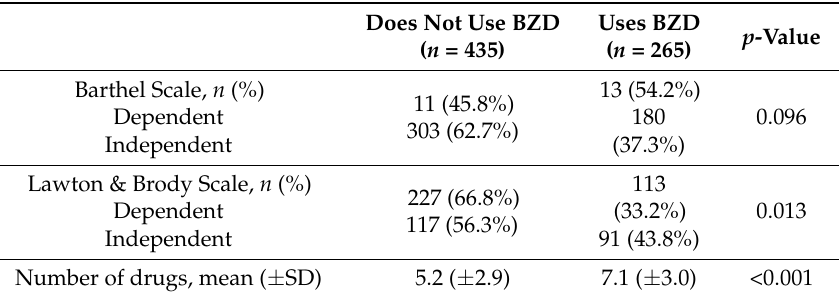
Table 3. Association between benzodiazepine use and different